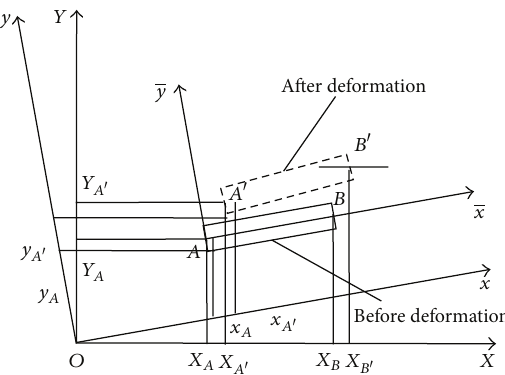
Figure4:Thekinematicrelationsofabeamelementbeforeandafter